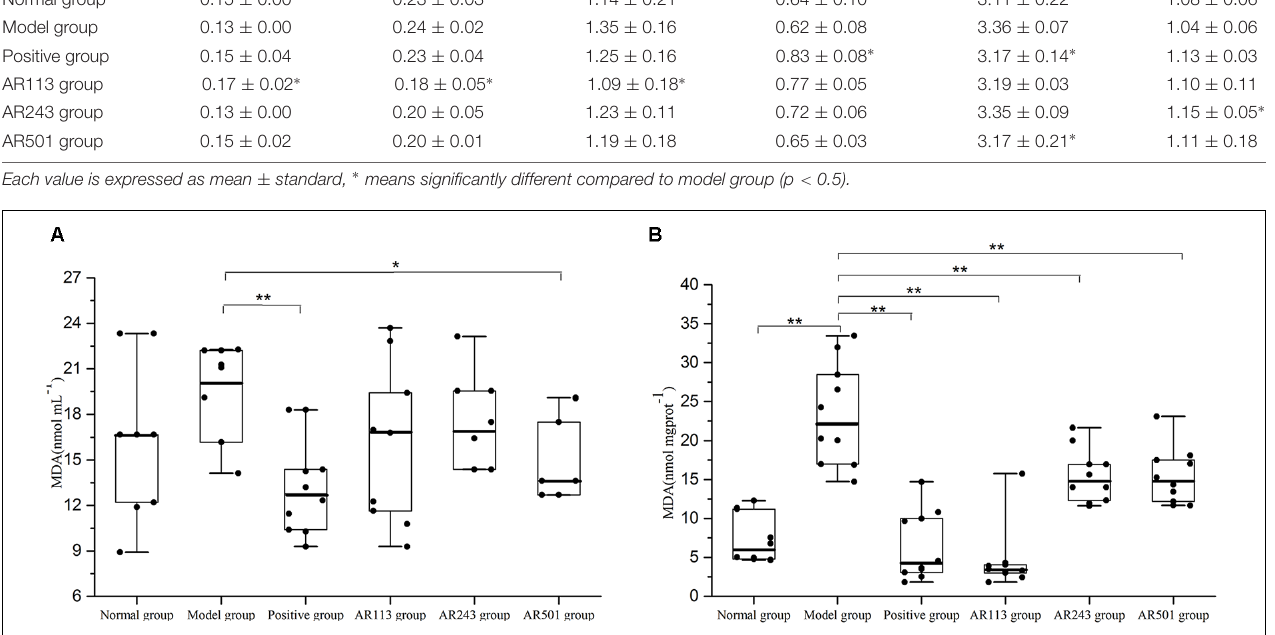
FIGURE 1 | Effect of LAB on oxidized oil induced levels of lipid peroxidation in serum (A) and liver (B) of mice. Value are expressed as means ± SD ( n = 10), ∗ p < 0.05 vs. model group. ∗∗ p < 0.01 vs. model group.